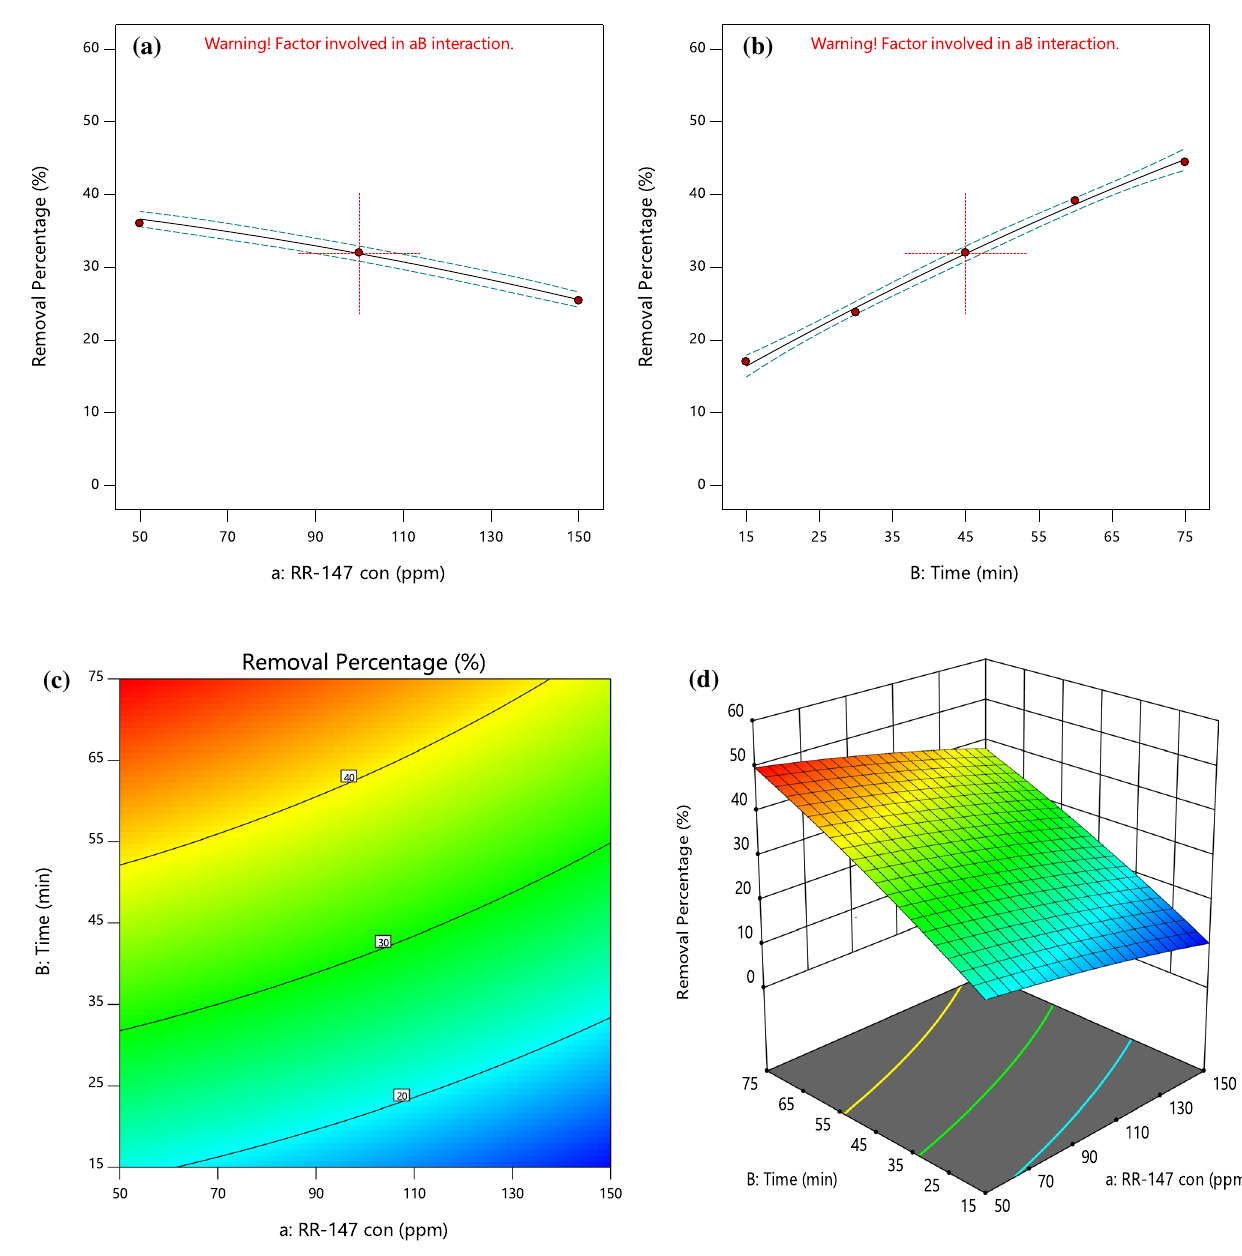
Fig. 5 Influence of a dye concentration, b light illumination time on the dye removal rate (%), c contour plot and d response surface plot accord- ing to RSM